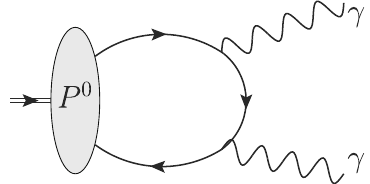
Fig. 3 The diphoton decay process of a neutral pseudoscalar meson P 0 (such as η , η c and η b